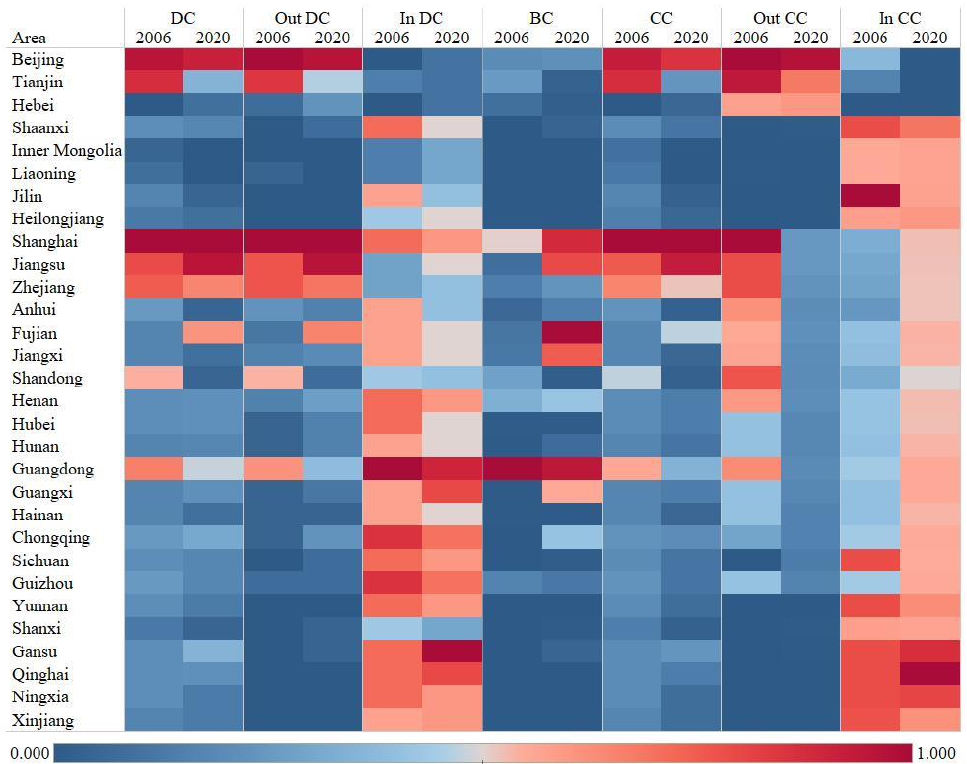
Figure 7. Individual centrality analysis of the IGGE correlation network. Note that DC represents the degree centrality, BC represents the betweenness centrality, and CC represents the closeness centrality. All the indicators are standardized.